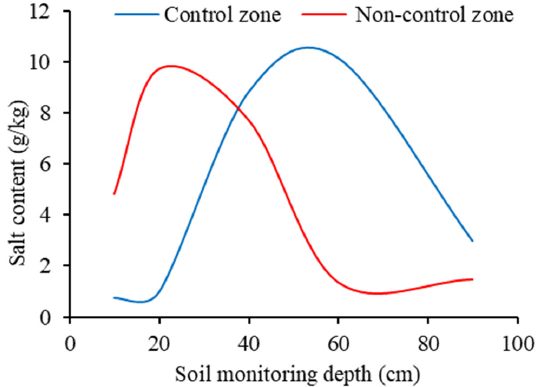
Figure 7. Variable quantity of the soil bulk salt content at different depths in control and non-control zones before and after groundwater control period.